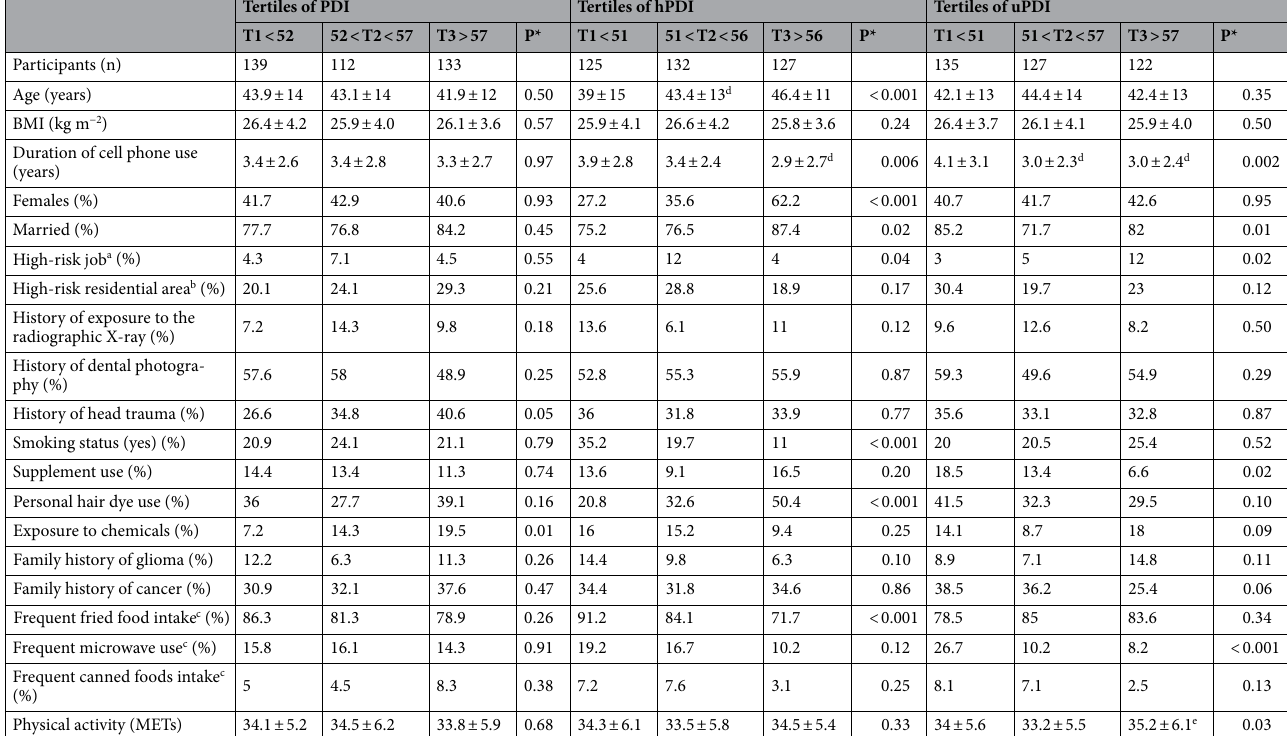
Table 2. Demographic characteristics and selected risk factors of the study participants across tertiles of PDI, hPDI, and uPDI scores. PDI overall plant-based diet index, hPDI healthy plant-based diet index, uPDI unhealthy plant-based diet index, MET metabolic equivalents. All values are mean ± SD or percent. a Farmers were considered as having a high-risk occupation. b Subjects who lived in places nearby electromagnetic fields and cell phone and broadcast antennas in the last 10 years were considered as living in high-risk areas. c Subjects who consumed fried food, microwave and canned foods at least twice per week were considered as frequent users. *Obtained from ANOVA with Bonferroni correction or Chi-square test, where appropriate. d Significant compared with T1. e Significant compared with